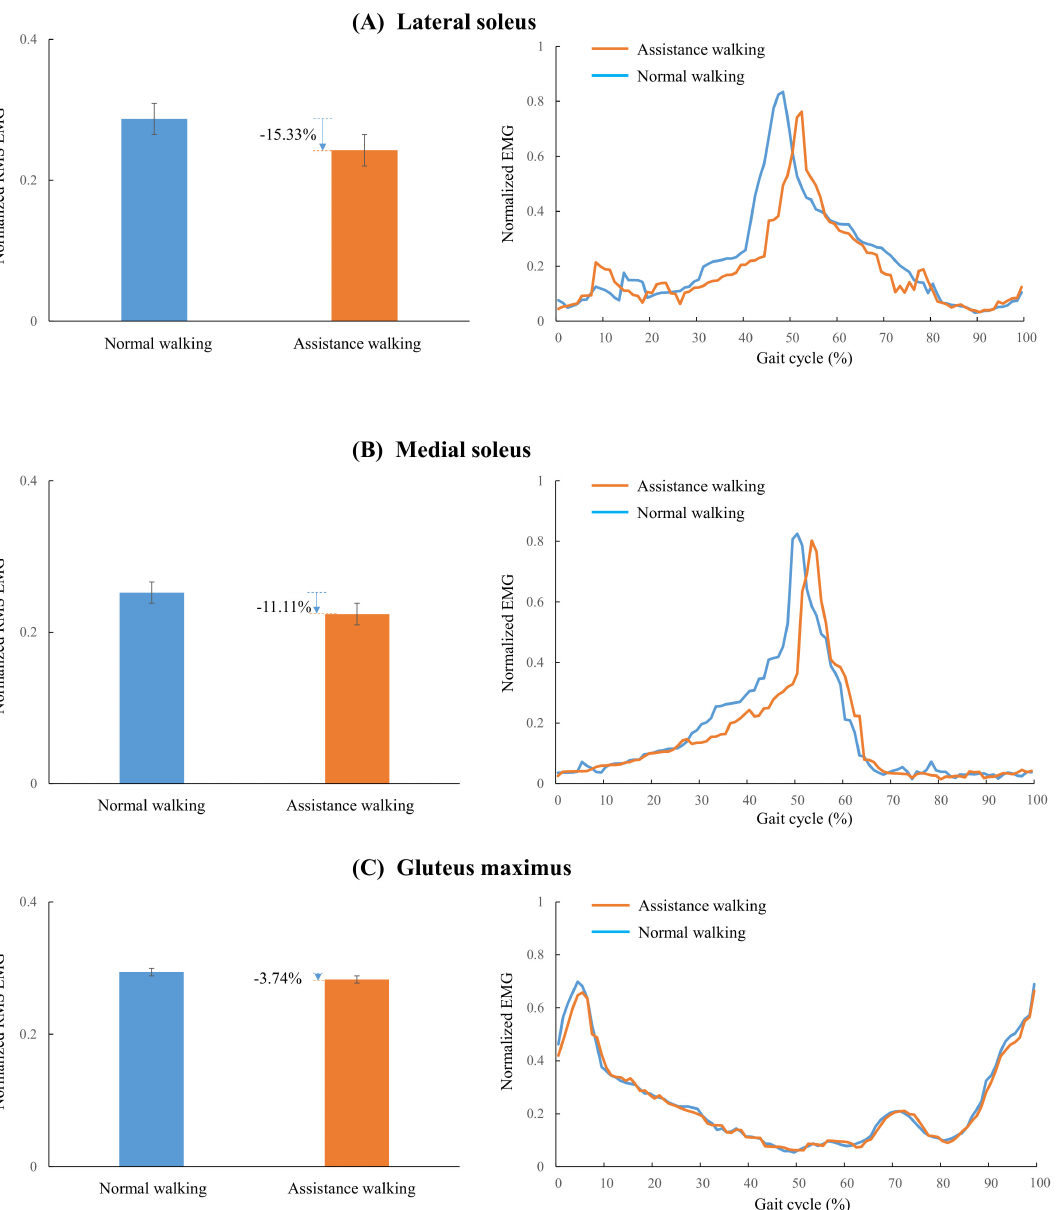
Figure 9. The muscle activities in assisted walking and normal walking. ( A ) Normalized RMS EMG and normalized EMG through the gait cycle of lateral soleus. ( B ) Normalized RMS EMG and normalized EMG through the gait cycle of medial soleus. ( C ) Normalized RMS EMG and normalized EMG through the gait cycle of